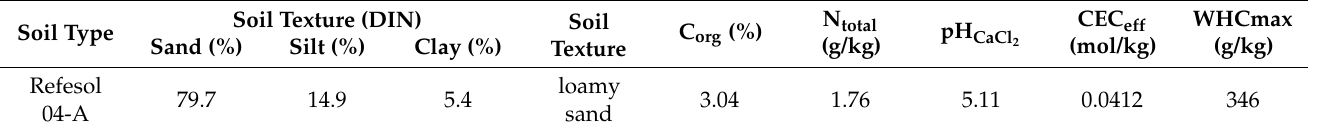
Table 1. Refesol 04-A soil characteristics (loamy